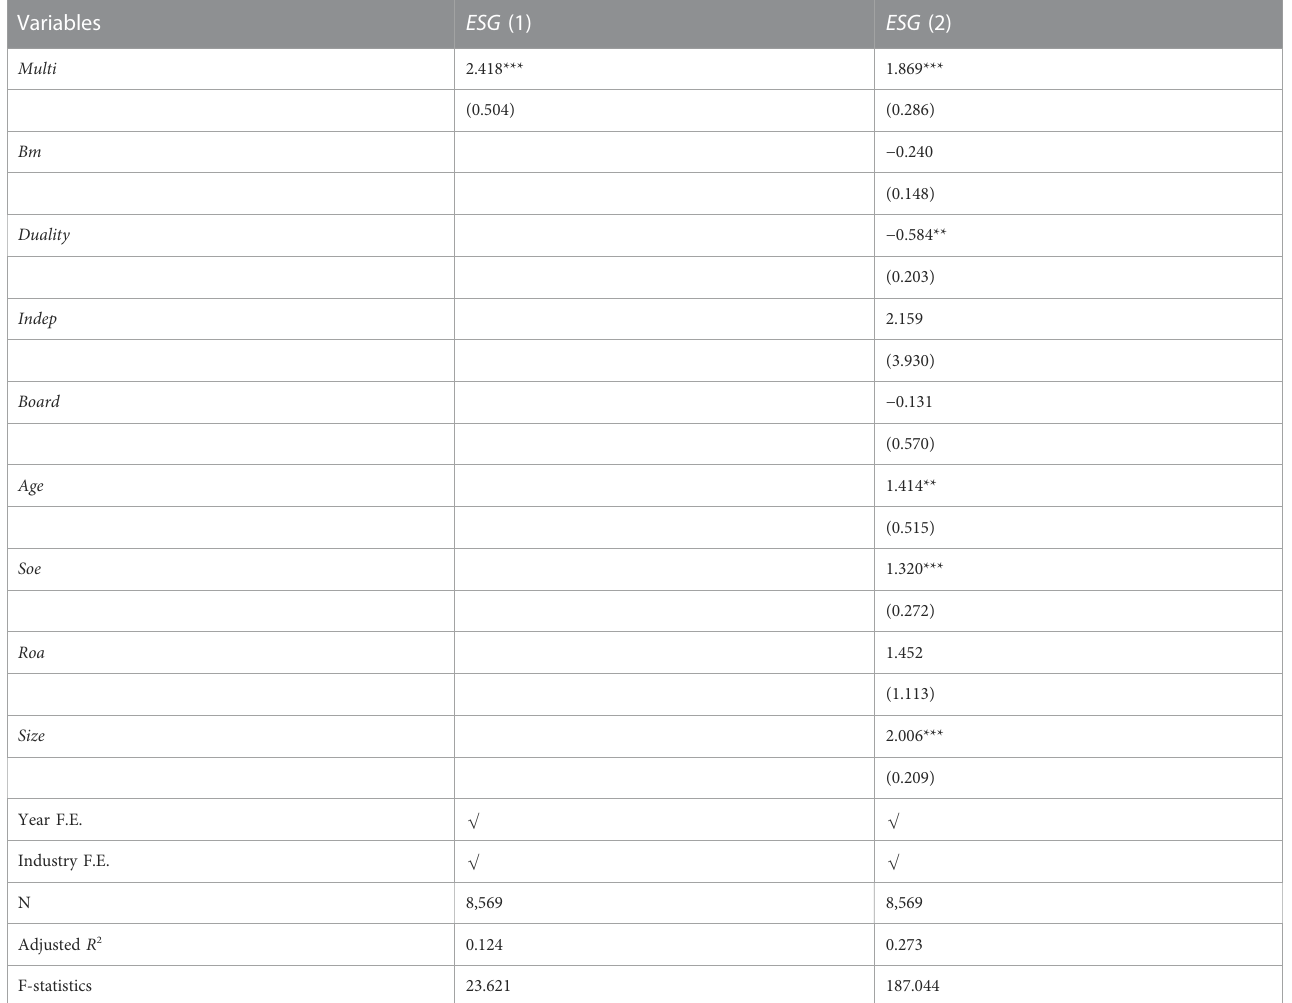
TABLE 3 Baseline regression results.